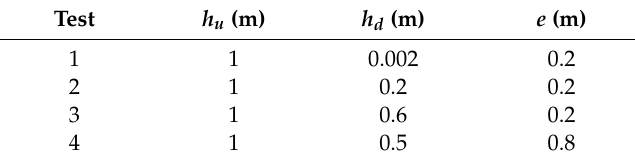
Figure 3. Plan view of the flume. Table 1. Initial conditions of the four numerical tests